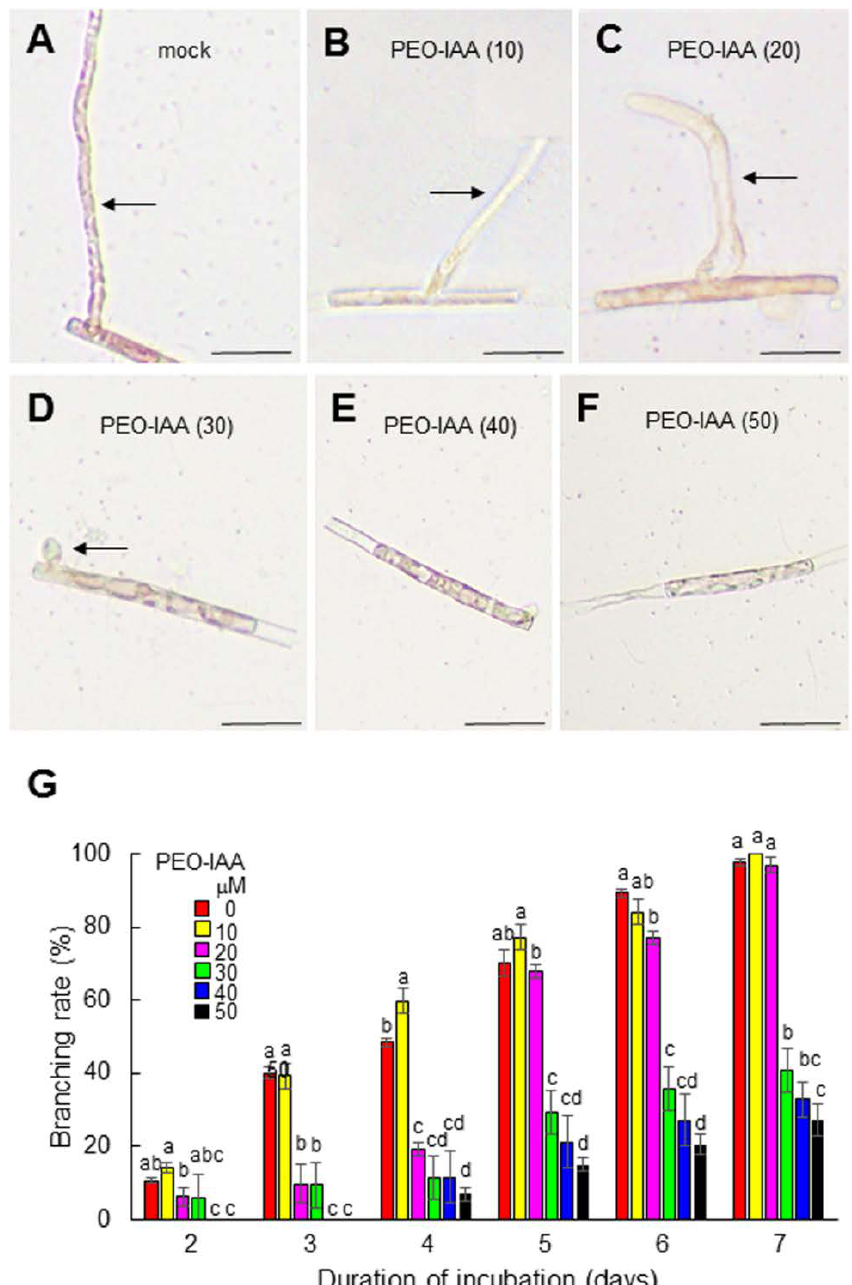
Figure 2. Effects of treatment with the auxin antagonist PEO-IAA on side-branch production in a single-celled conchocelis. ( A – F ) Photographs of typical effects of the auxin antagonist on the growth of side branches from single-celled conchocelis treated with 0, 10, 20, 30, 40, or 50 μM PEO-IAA for 7 days. Arrows indicate side branches. Scale bars: 50 μm. ( G ) Changes in branching ratios following the treatment of single-celled conchocelis with various concentrations of PEO-IAA. Side branch formation was observed in single-celled conchocelis cultured in various concentrations of PEO-IAA for 7 days, and the number of conchocelis with branches at 2, 3, 4, 5, 6, and 7 days after treatment was counted under a microscopic to calculate the branching rate. Error bars indicate the standard deviation of triplicate independent experiments ( n = 3), and different lowercase letters denote significant differences in branching rate, as determined by Tukey’s test ( p < 0.05) for each set of incubation